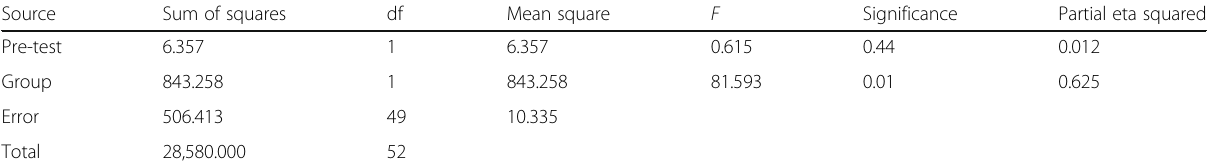
Table 7 Result for ability to maintain interactions with others between the two intervention groups